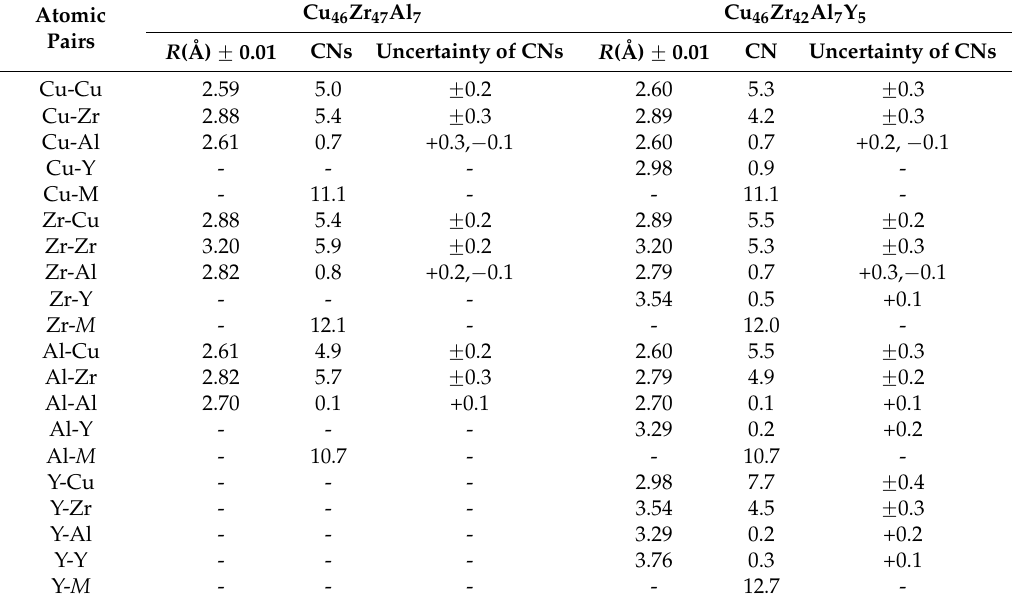
Table 1. The first ‐ shell atomic ‐ pair information deduced from the reverse Monte ‐ Carlo (RMC) ‐ simulated structural models of Cu 46 Zr 42 Al 7 Y 5 and Cu 46 Zr 47 Al 7 samples, including coordination numbers (CNs) and atomic ‐ pair distances ( R ). Note that M denotes Cu, Zr, Al, or Y. The Goldschmidt radii of Zr, Cu, Y, and Al are 1.60 Å, 1.28 Å, 1.80 Å, and 1.43 Å, respectively. Atomic Pairs